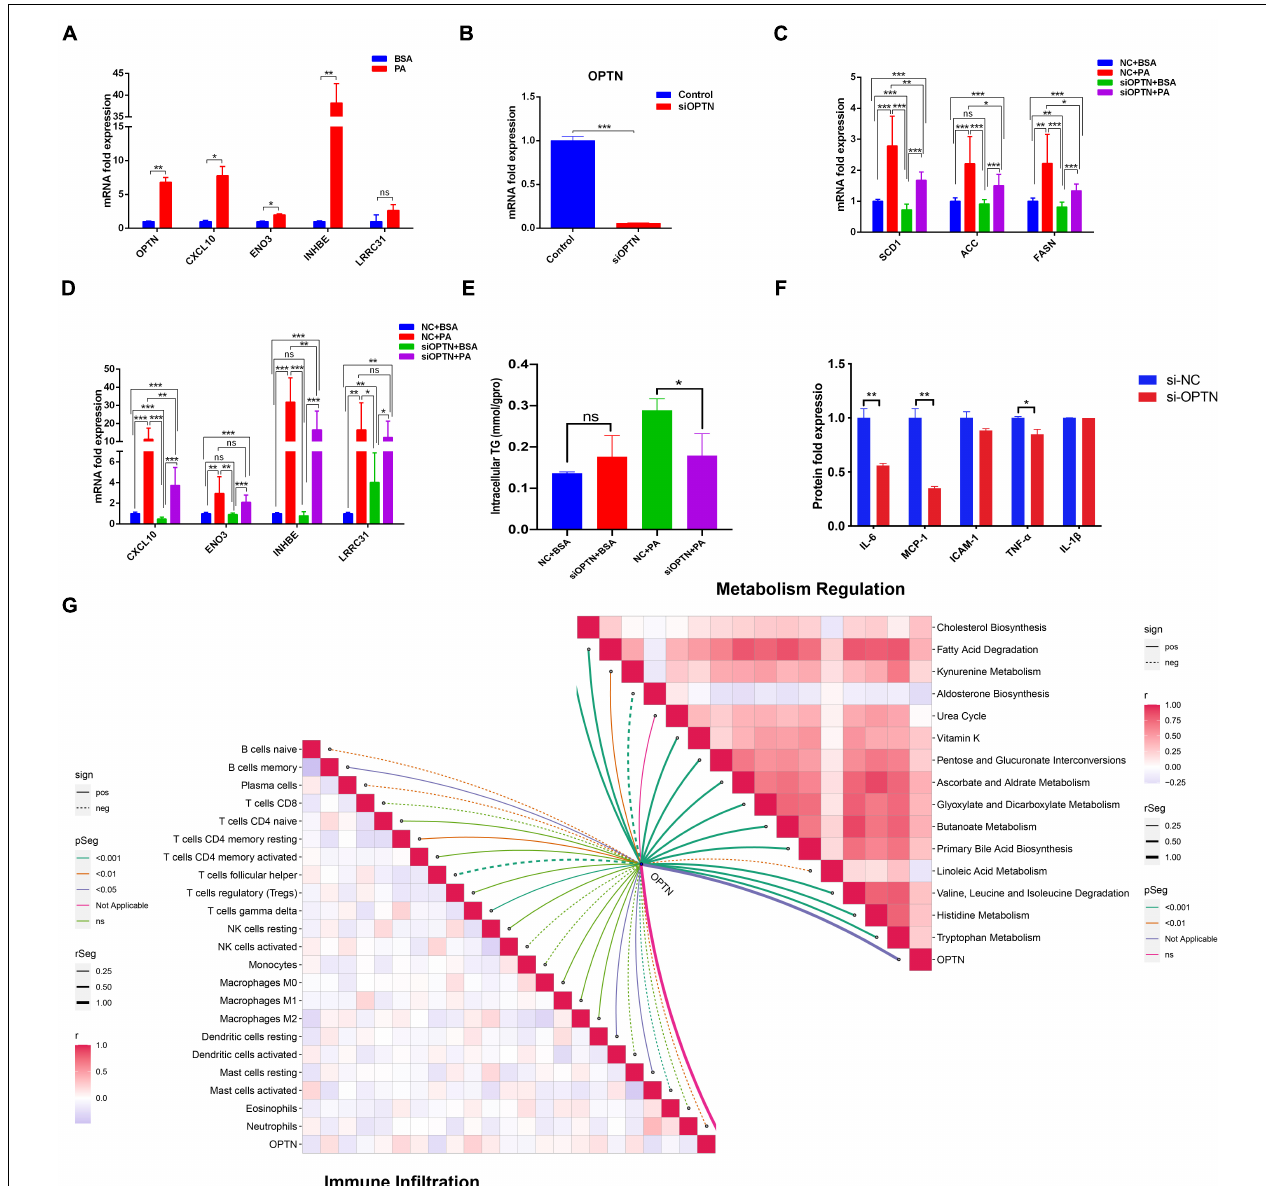
FIGURE 6 | Target gene validation in HepG2 cell. (A) Expression of 5 hub genes in HepG2 cell after stimulated by palmitic acid. (B) Efficacy of OPTN knockout in HepG2 cell. (C) Expression of adipogenesis related genes after OPTN knockdown. (D) Expression of other hub genes after OPTN knockdown. (E) Effect of OPTN knockdown on the intracellular triglyceride content in HepG2 cell. (F) Effect of OPTN knockdown on the release of proinflammatory cytokines in HepG2 cell. (G) Metabolic and immune regulation of OPTN. * p < 0.05, ** p < 0.01 and *** p <